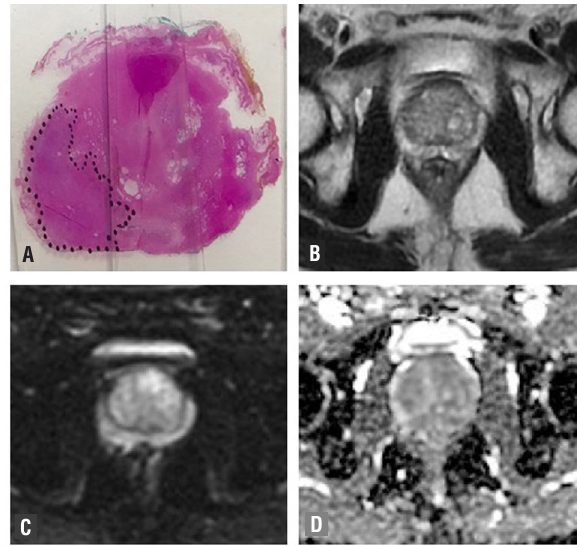
Figure 1 - Male, 69-year-old patient with prostate cancer Gleason 8 (4+4). (a) RP specimen shows index lesion of 22mm, Gleason 4+5=9 prostate cancer. MRI demonstrate low signal 12mms lesion on T2w images (arrow) in the peripheral zone confined to the prostate (b), there is a focal area of hyper signal in DWI with b value =800 (c) and reduced ADC (d). No extracapsular extension is seen in MRI. PIRADS: T2WI=4/5; DWI=4/5.